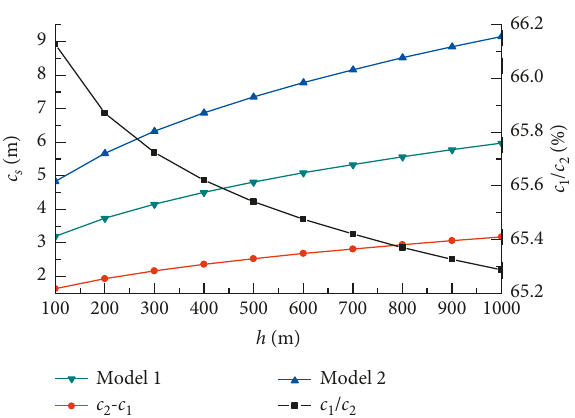
Figure 8: Diagram of minimum thickness with the stage